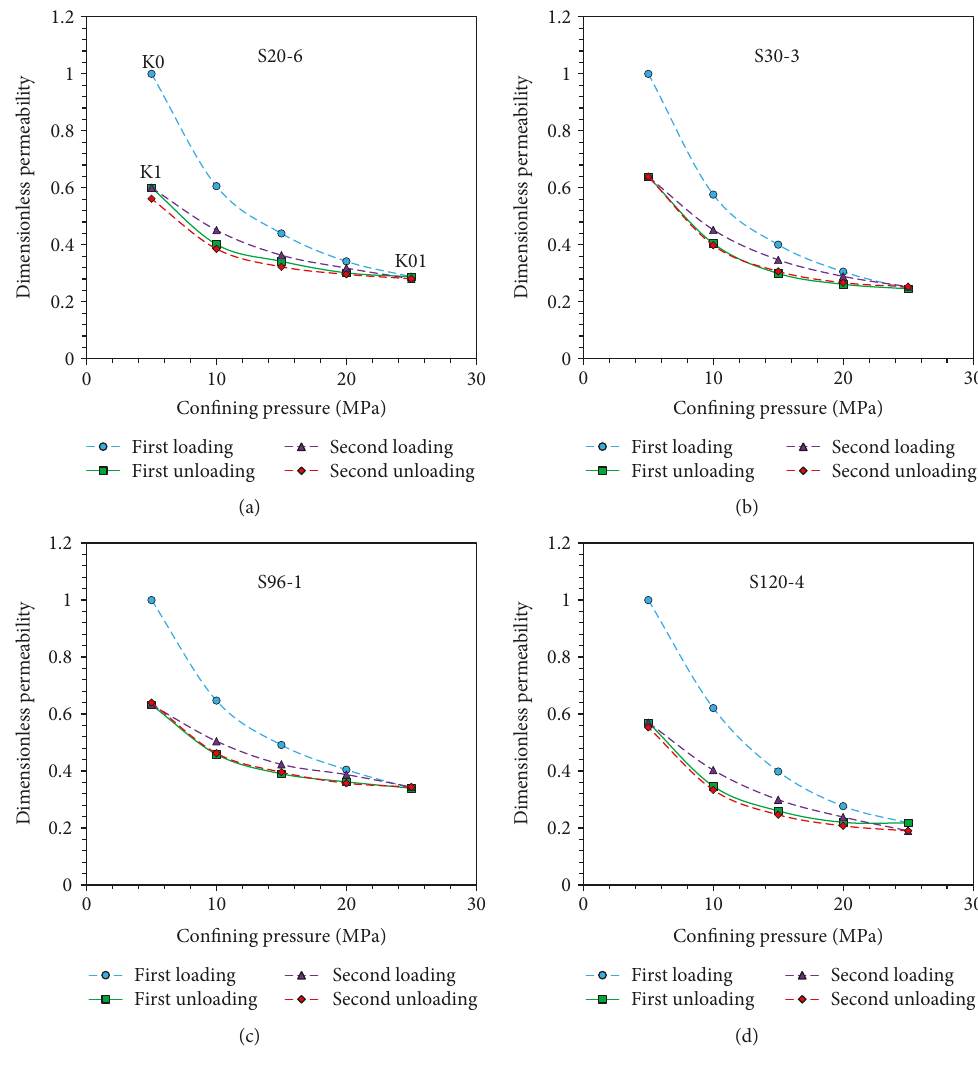
Figure 10: Stress sensitivity of H8